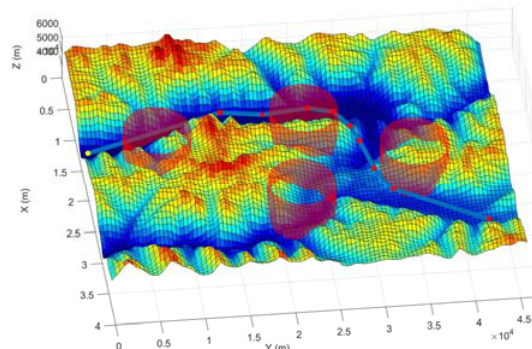
Fig. 7. UAV trajectory computed by the FPA in North-East Afghanistan (Top-left corner is